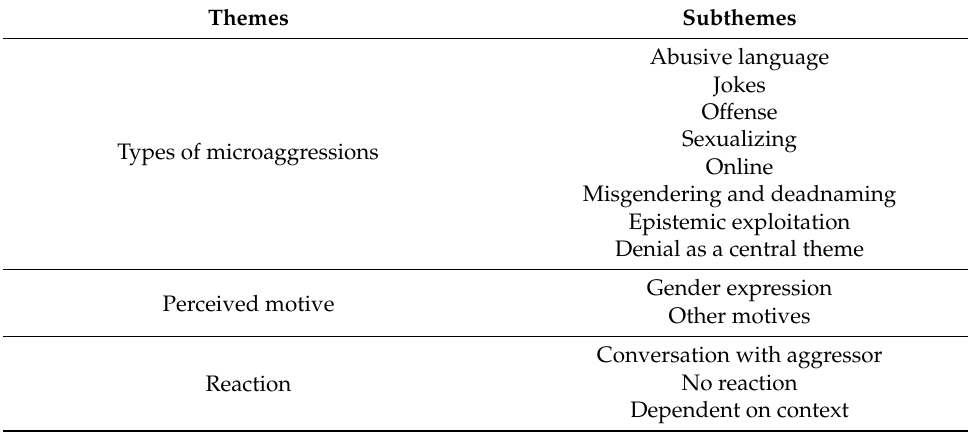
Table 1. Experiences of microaggressions: themes and